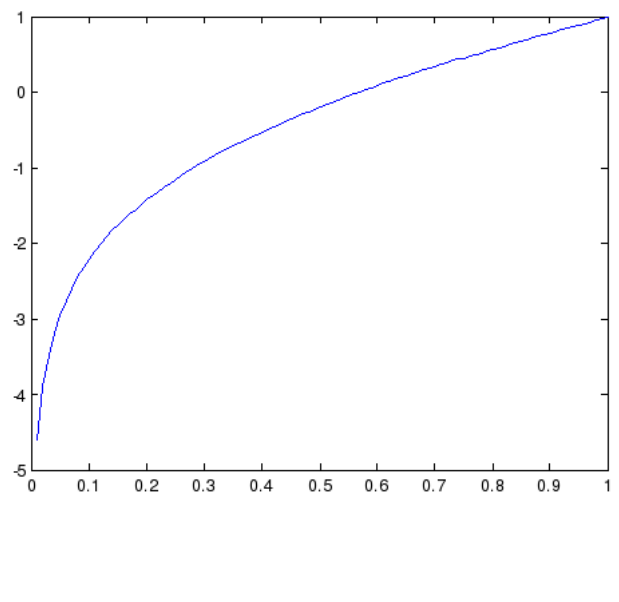
Figure 2. Function for updating reputation